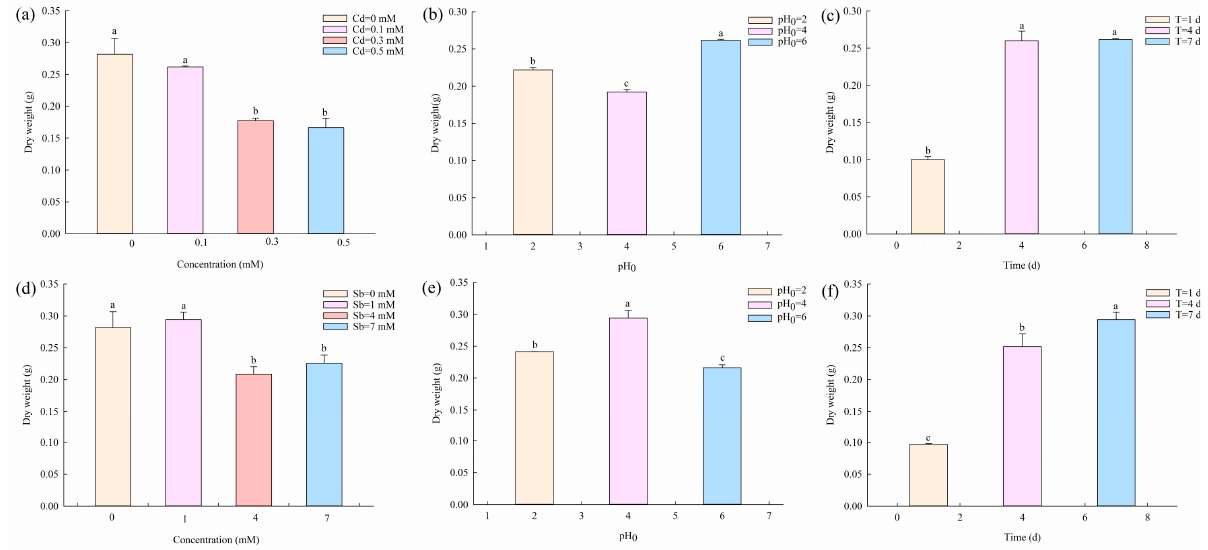
Figure 5. Effects of different factors on the dry weight of XK10 in the adsorption process. ( a ) Initial concentration for Cd adsorption; ( b ) Initial pH 0 for Cd adsorption; ( c ) Adsorption time for Cd adsorption; ( d ) Initial concentration for Sb adsorption; ( e ) Initial pH 0 for Sb adsorption; ( f ) Adsorption time for Sb adsorption. Results are expressed as mean ± SD of three replicates. Different letters indicate significant differences between the same indicators ( p < 0.05).